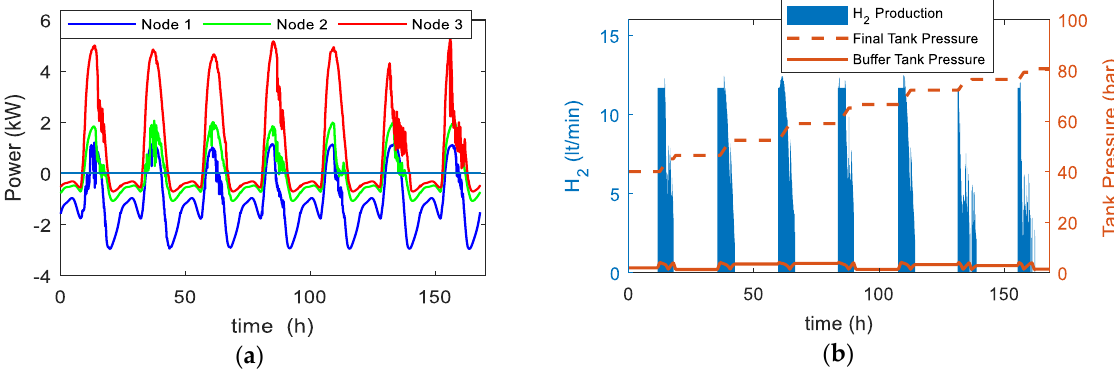
Figure 18. ( a ) Available power at each node in weekly operation; ( b ) Hydrogen production and storage tanks pressures.